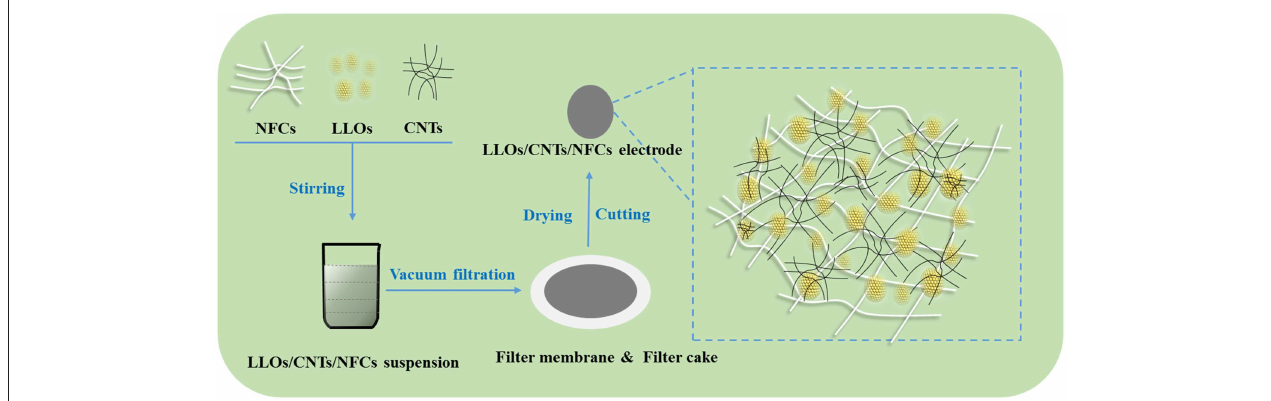
FIGURE 1 | Flow diagram of the preparation procedure of flexible LLOs/CNTs/NFCs